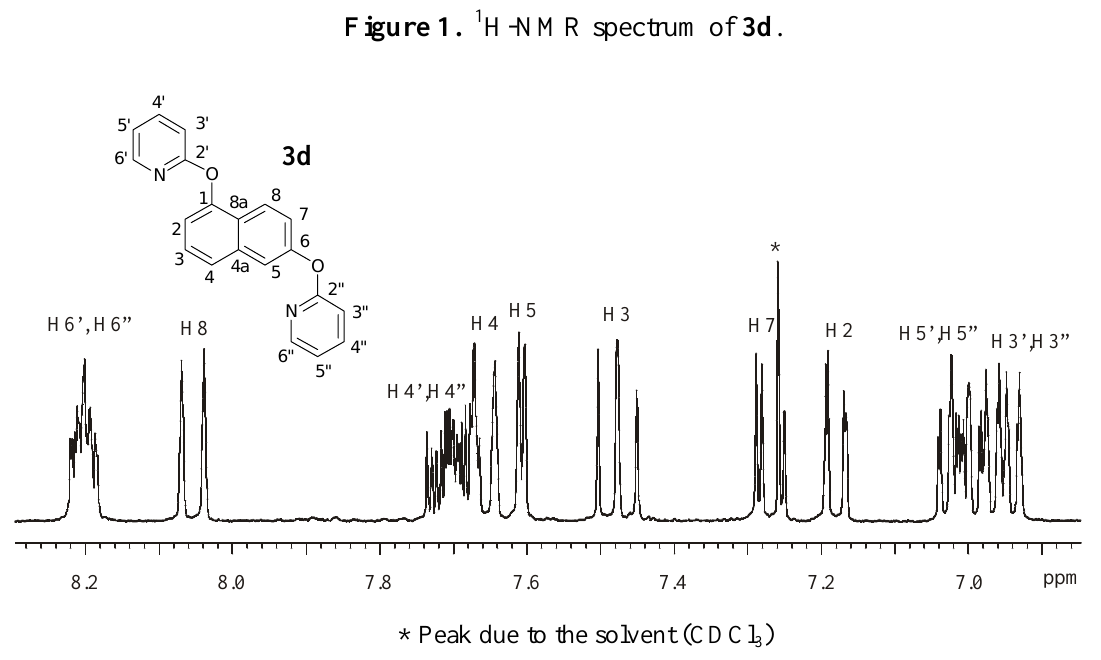
Figure 1. 1 H-NMR spectrum of 3d